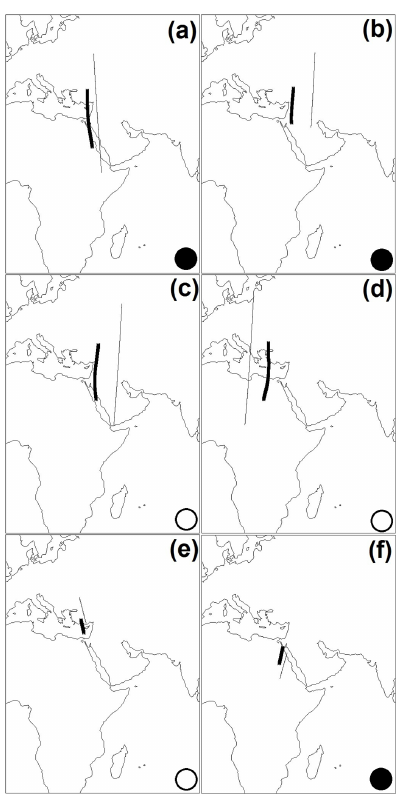
Figure 2. Set of maps show the satellite track (thin line) and the F region (thick line) pierce points over northern Africa and the eastern Mediterranean. The local night and day times during the satellite passes are indicated by black filled and white open circles at the bottom right corner of each map. The CIDR passes (alphabetically sequenced from a to f ) were detected on 22 January 2009 at 01:21, 02:56, 12:48, 14:36, 15:44UT and on 23 January 2009 at 04:10UT, respectively.